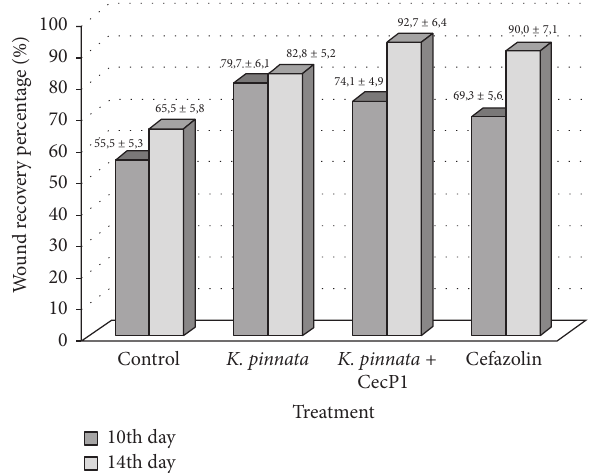
Figure 3: Testing healing of the wounds infected with S. aureus. Wound recovery percentage at 10th and 14th days after beginning of curing (M ± Std . Err . ) is shown.